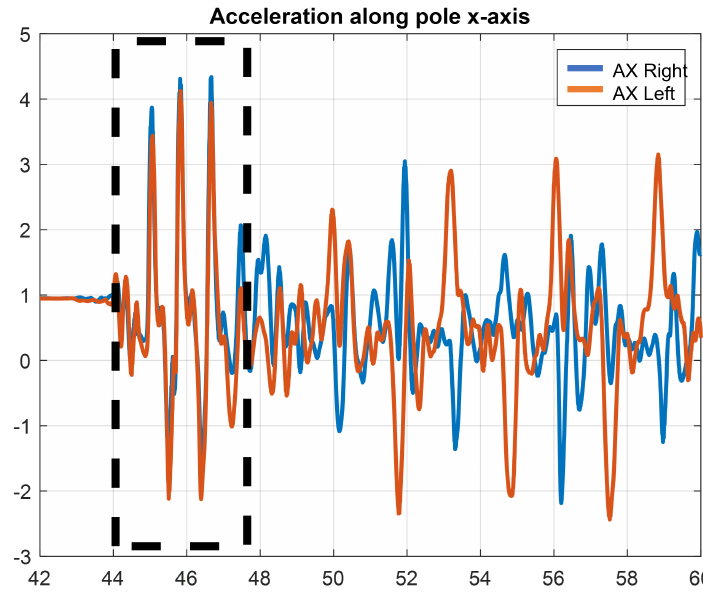
Figure 6. Pole acceleration along x